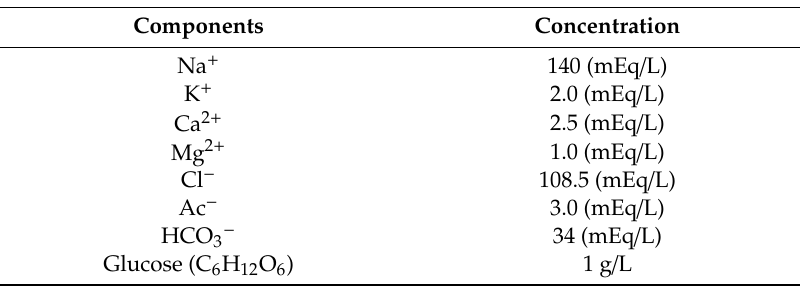
Table 1. A concentrated dialysis solution was used in this study. The Electrolytic Concentration of Concentrated Dialysis Solution (K-Bicart) Components